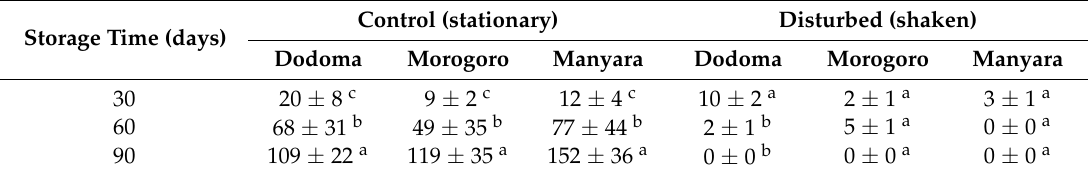
Table 4. Number of live S. zeamais for the control and disturbed treatments after 30, 60, and 90 days. Control (stationary) Disturbed (shaken) Storage Time (days) Dodoma Morogoro Manyara